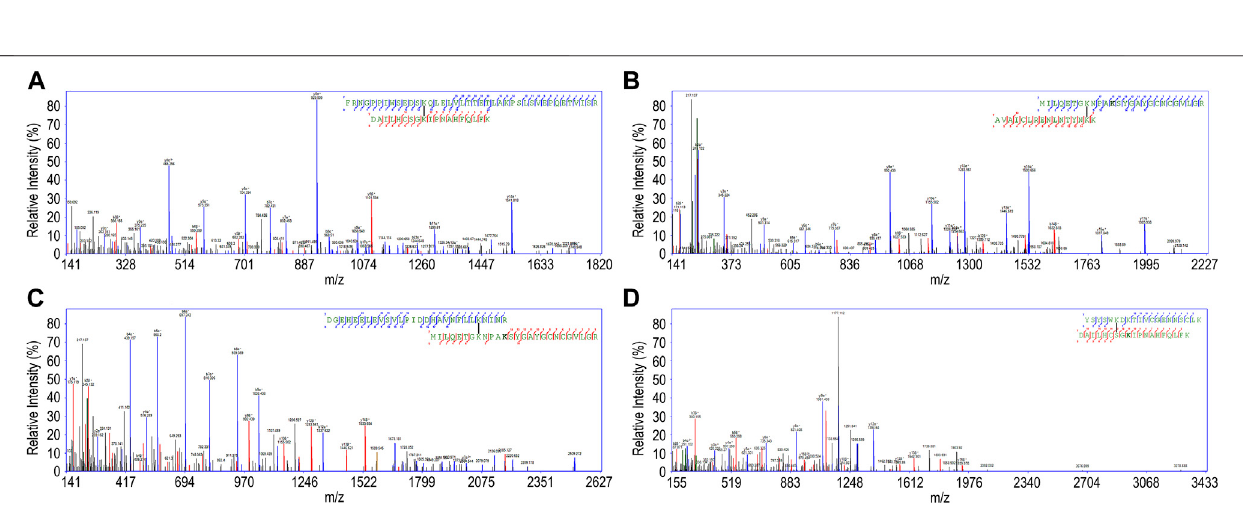
FIGURE 4 | Representative good-quality fragmentation spectra of peptides cross-linked with BS 3 , interpreted by the SIM-XL software, and manually veri fi ed. (A) Intra-proteinlinkfromDM64(scan#27,856,SIM-XLprimaryscore6.74); (B) Intra-proteinlinkfrommyotoxinII(scan#20,073,score4.62);Inter-proteinlinkfromDM64- myotoxin II complex: (C) Scan # 28,261, score 5.86; (D) Scan # 21,754, score 4.32. For each spectrum, the sequences of the cross-linked peptides are shown, along with all observed b- and y-ions (blue and red lines, respectively for α - and β -peptides) and the position of the linker (black